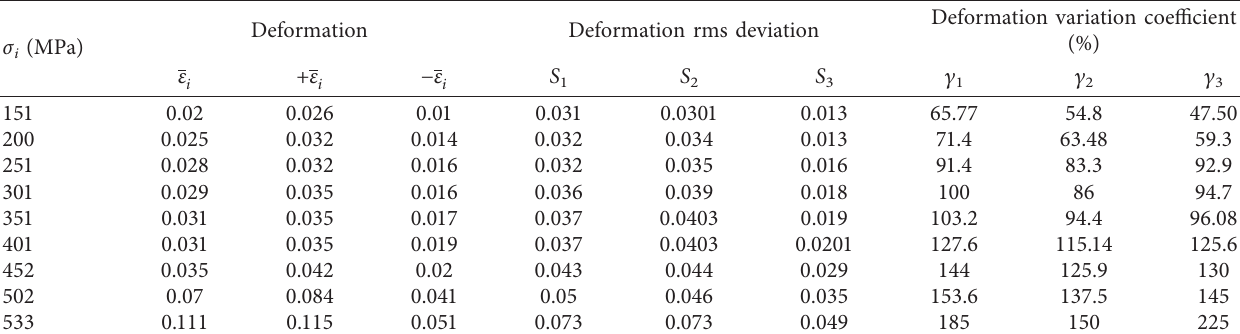
Table 9: Experimental data characterizing the microplastic deformation of the deposited samples of steel S 40 after normalization (group